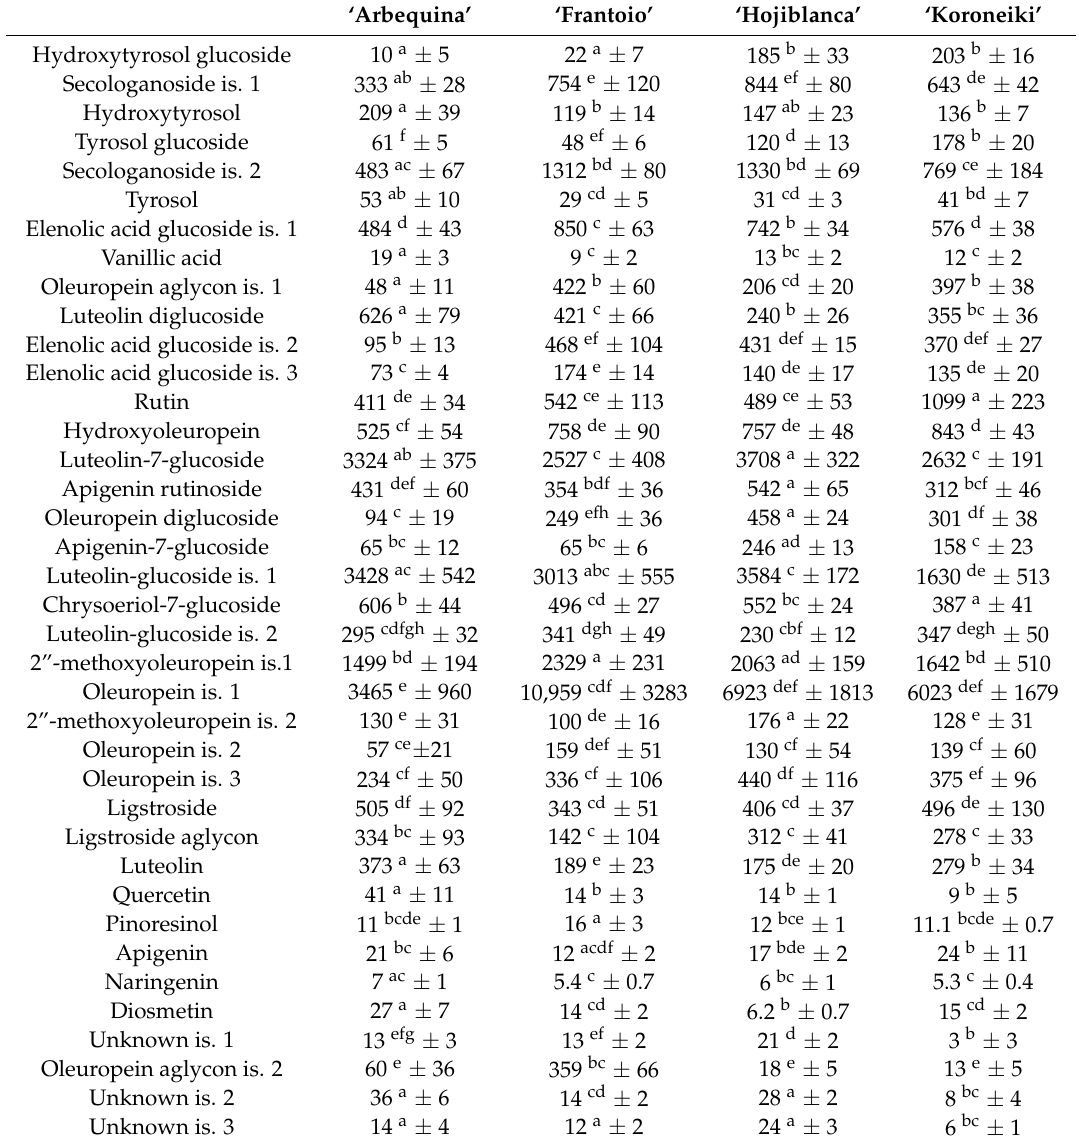
Table 2. Found content (average values and standard deviation, mg/kg DW) of the determined phenolic compounds in the evaluated olive leaves cultivars. ANOVA results are included; significant differences in the same row are indicated with different superscript letters (comparison among the 11 cultivars investigated in this study, p <